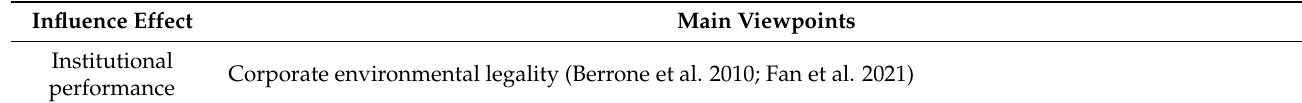
Table 3. Main viewpoints on the influential effect of family firm environmental